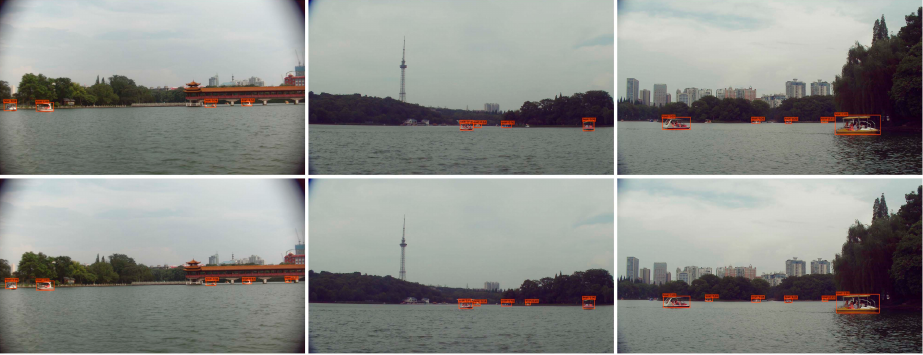
Figure 8. The detection results of FASSD compared with SSD. The second row of each subfigure shows the detection results of FASSD.